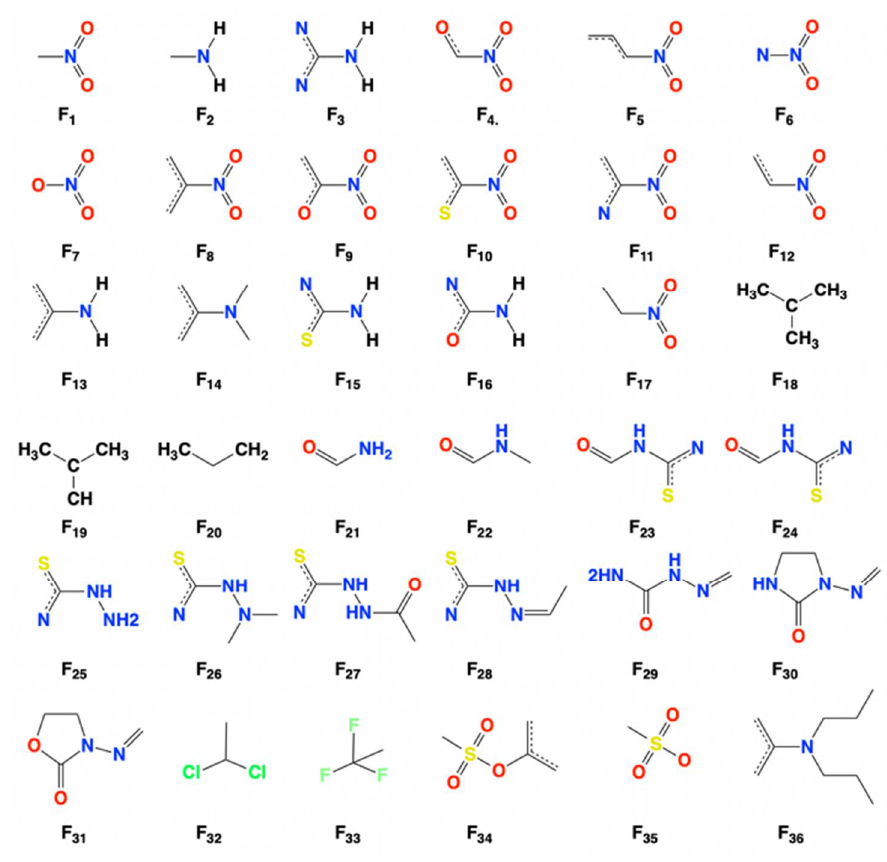
Figure 2. Molecular fragments contributing to carcinogenic activity of nitrocompounds. Table 2. Molecular fragments related to carcinogenic activity. Table 3. QSAR studies on the toxicity effects of